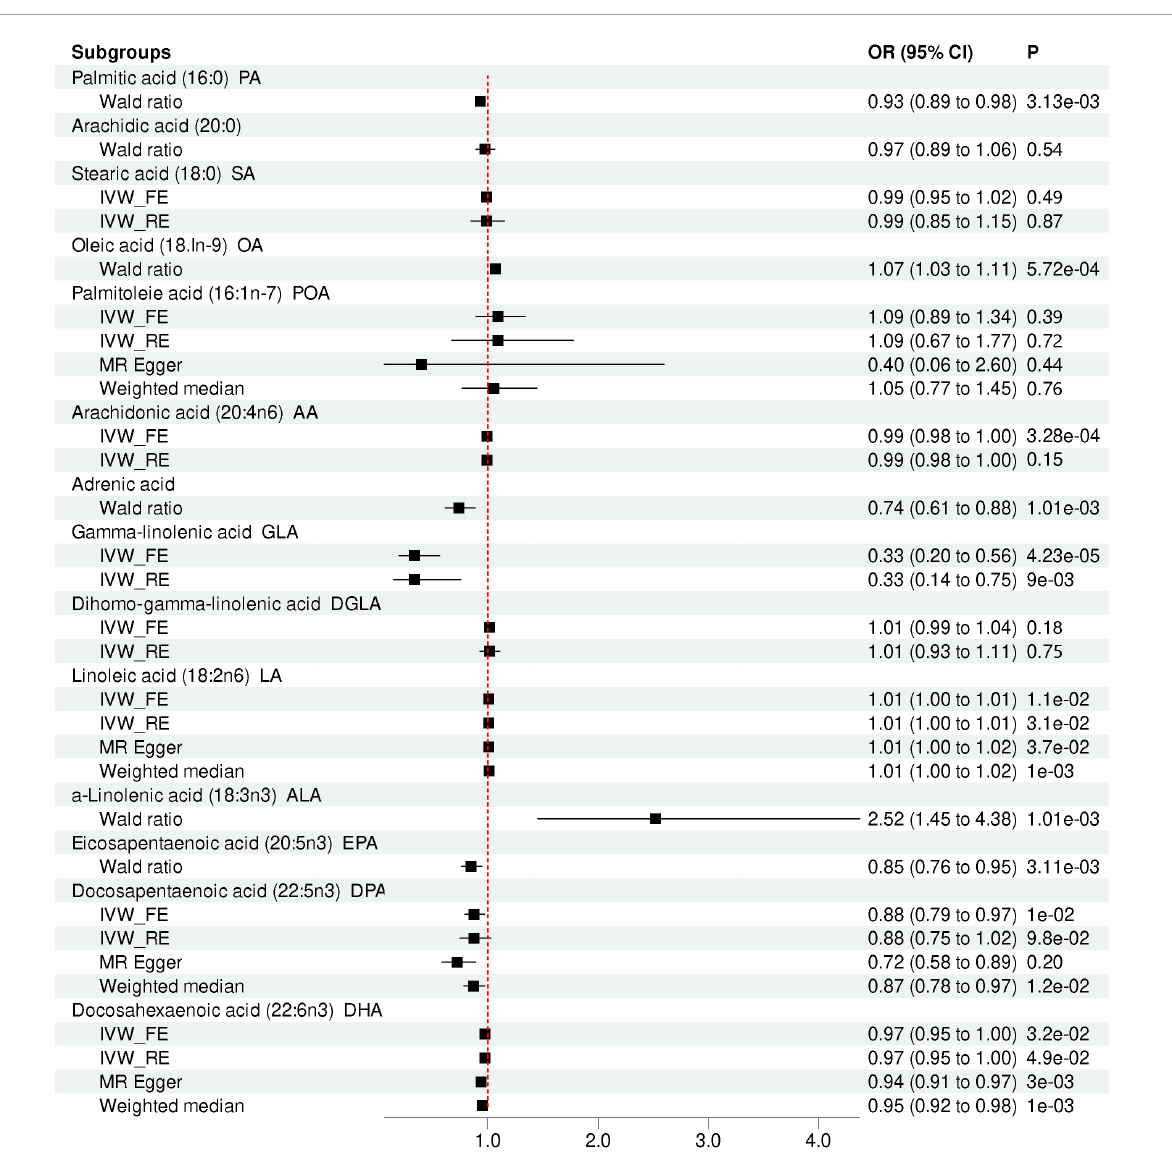
FIGURE2 Mendelian randomization analysis showing the effects of different type of FA on depression risk. IVW_FE: fixed-effects inverse-variance weighted model; IVW_RE: random effect inverse variance weighted; CI, confidence interval; OR, odd